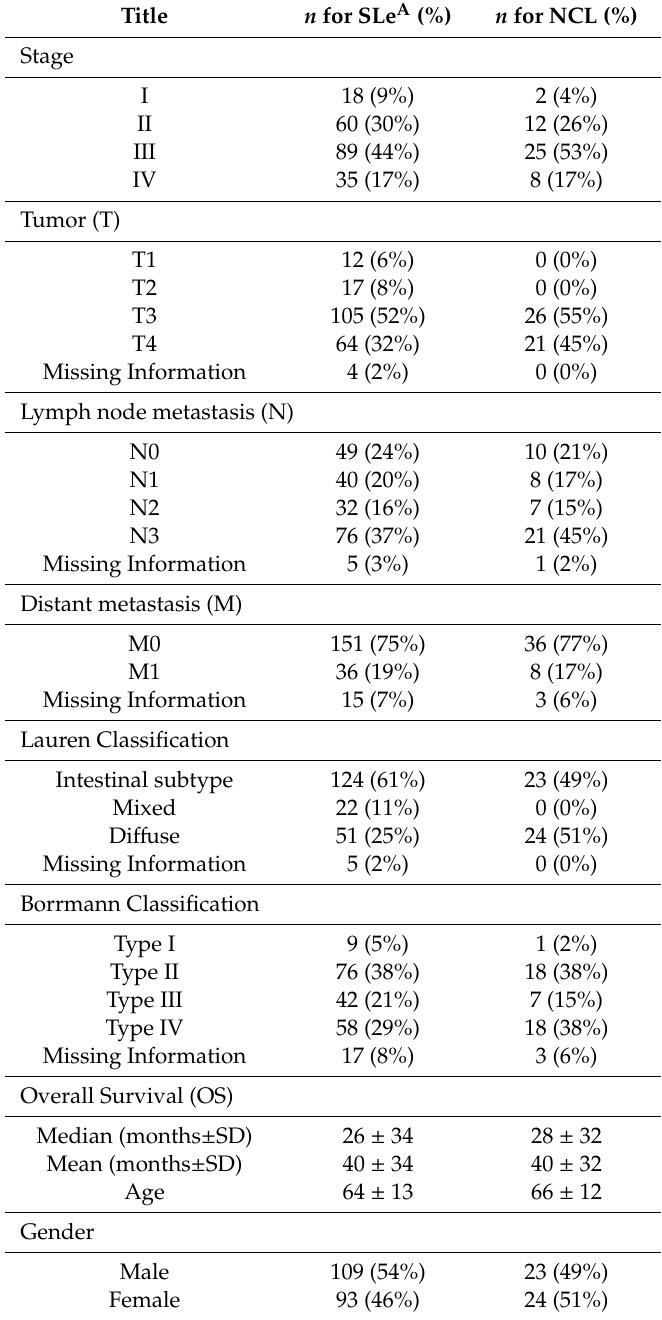
Table 2. Clinicopathological data of patients included in the SLeA ( n = 202) and for NCL analysis ( n =